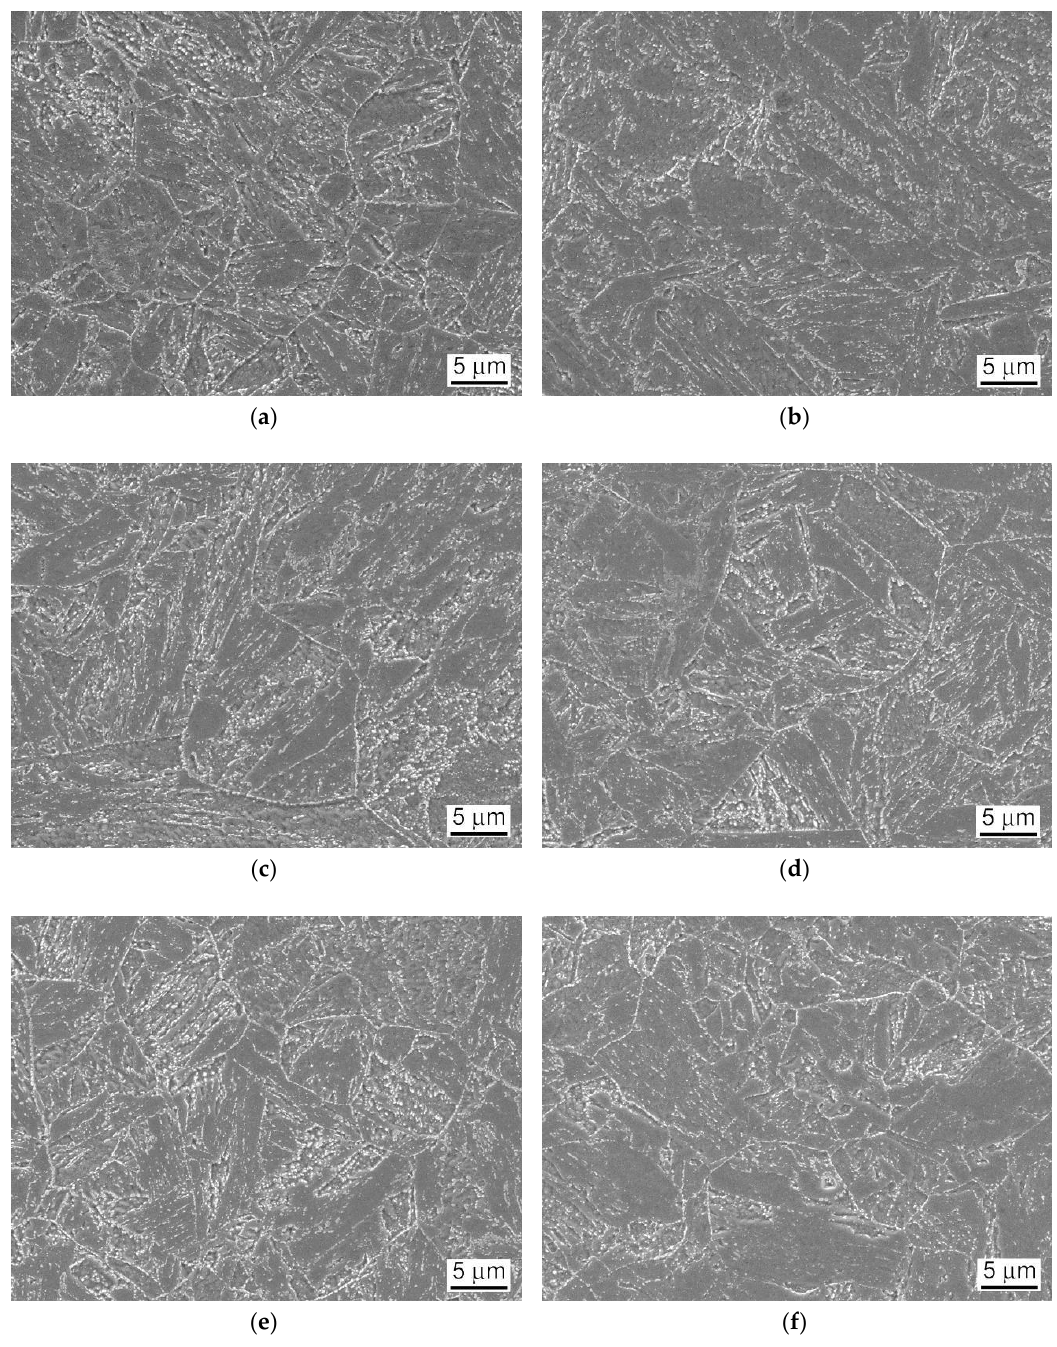
Figure 7. SEM-micrographs of individual microstructural zones of T92/T92 weldment after the renormalizing-and-tempering PWHT-2: ( a ) BM; ( b ) former SC-HAZ; ( c ) former IC-HAZ; ( d ) former FG-HAZ; ( e ) former CG-HAZ; and ( f ) WM.